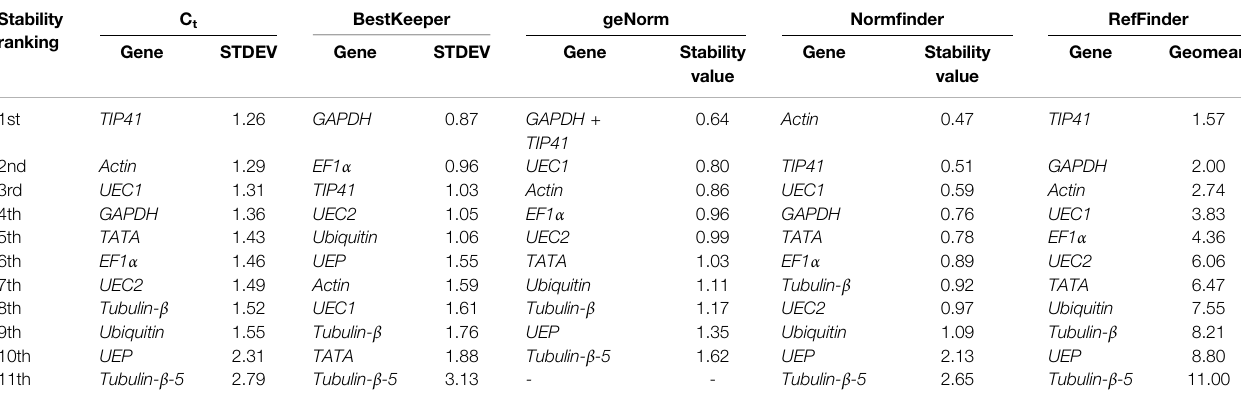
TABLE 7 | Stability ranking of 11 candidate reference genes with tissues from young (matured leaf and stem) and under drought (matured leaf) and adult (matured leaf and fl ower bud) of R. delavayi . Stability